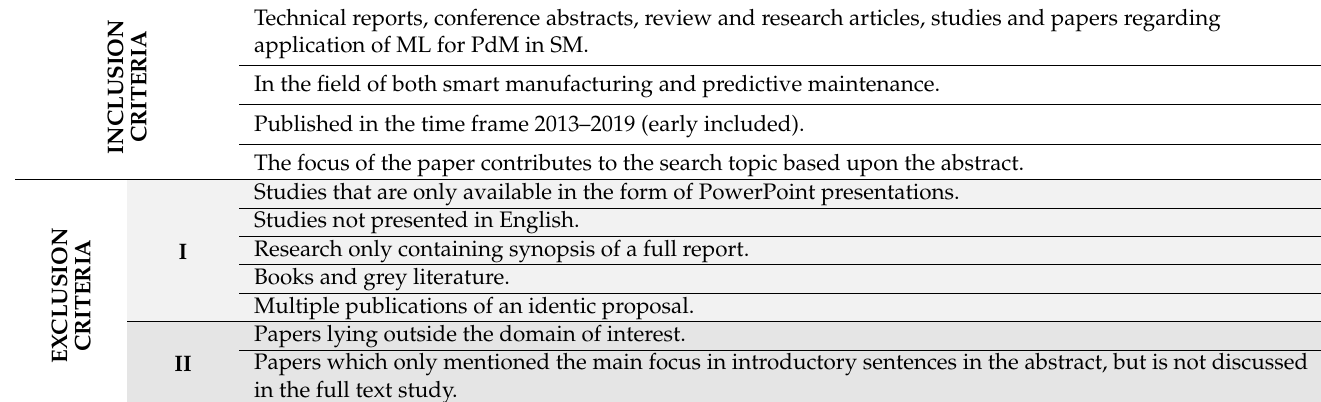
Table 2. Inclusion and exclusion criteria for selection of relevant